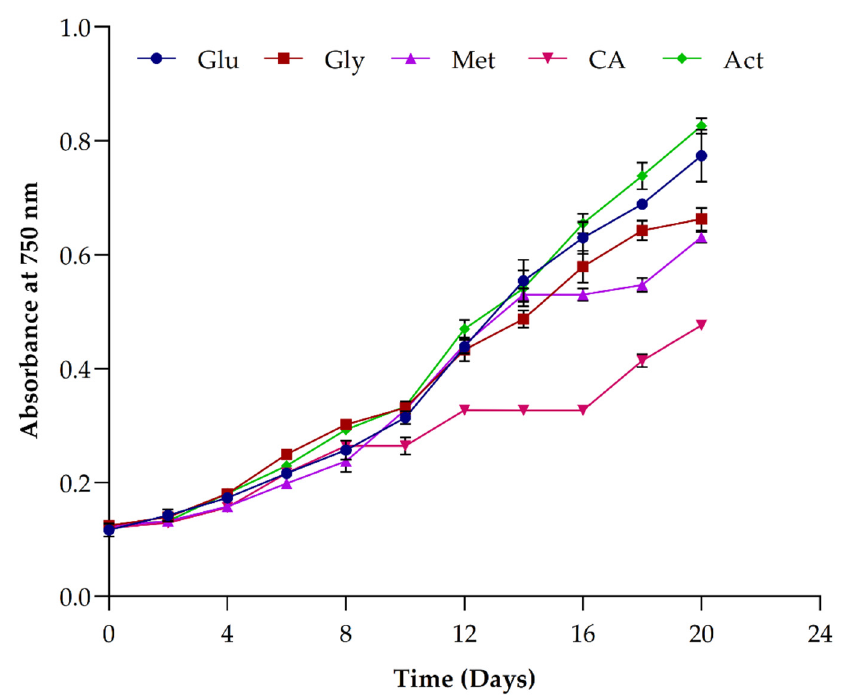
Table 1. Biomass and biomolecule production in different carbon sources ( n = 3), ± (standard devi- ation of replicate data).